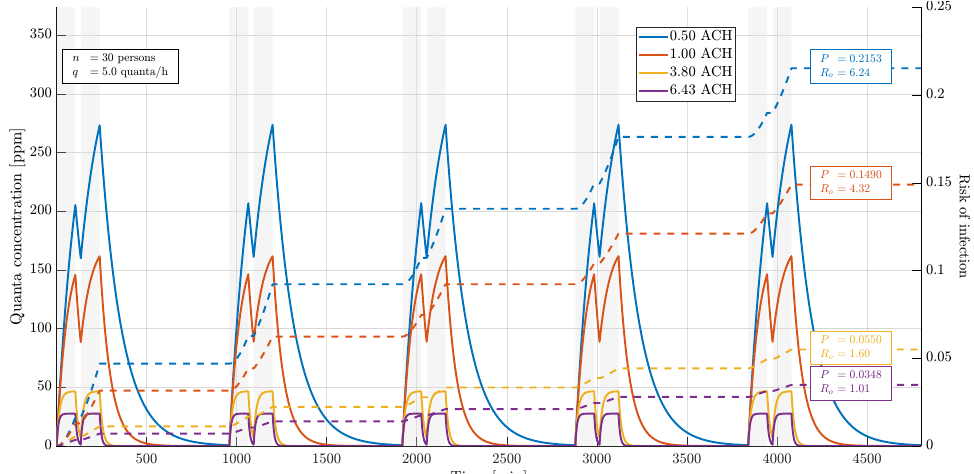
Figure 11. Transmission risk for different ventilation rates, evaluated with artificial quanta con- centration curves and the Gammaitoni-Nucci model. Full curves represent quanta concentrations and dashed curves represent the probability of infection. The grey shaded background identifies occupation periods. The coloured boxes detail the probability of infection and the basic reproduction number by the end of the week.